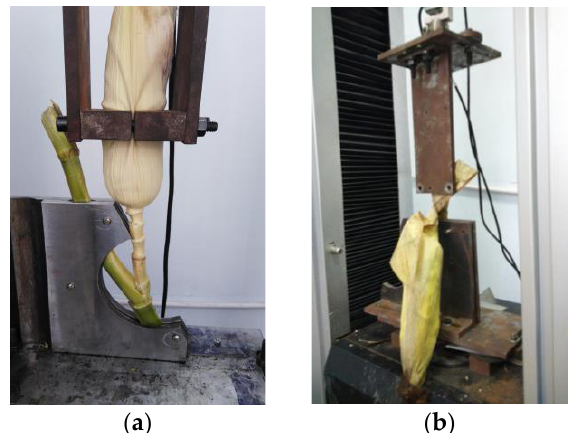
Figure 3. The process of mechanical test. ( a ) Tensile breaking test of corn ear. ( b ) Bending fracture test of corn ear.